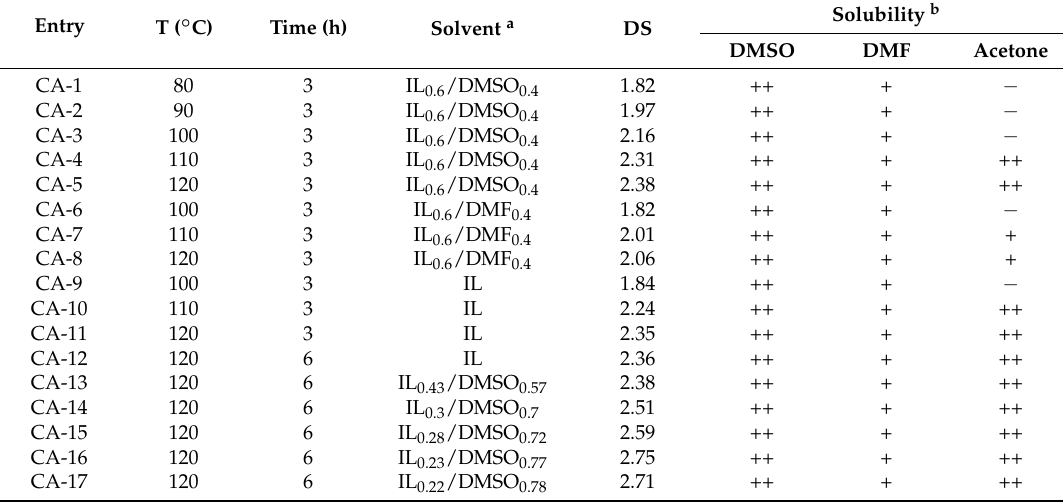
Table 1. Conditions of cellulose acetylation in different cosolvents and the solubility of the obtained CA. Entry T ( ◦ C) Time (h) Solvent